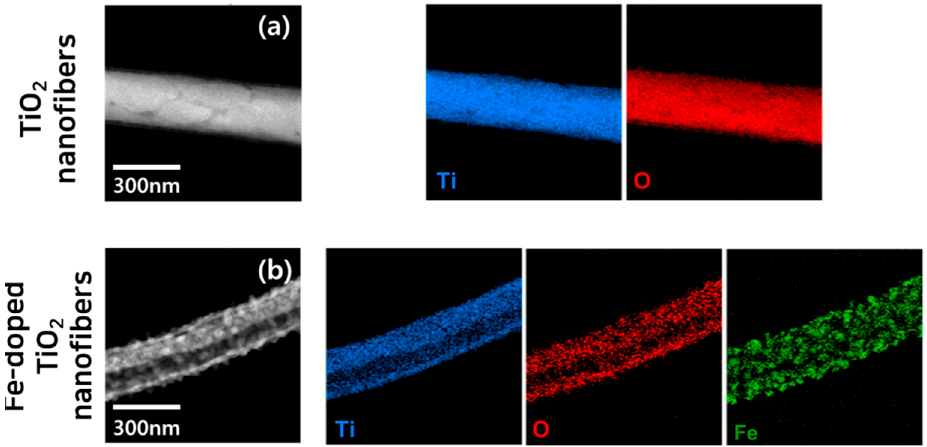
Figure 5. EDS map data of each nanofiber: ( a ) TiO 2 nanofibers and ( b ) Fe-TiO 2 nanofibers Selected area electron diffraction results for each fiber are shown in Figure 6a,b. Both